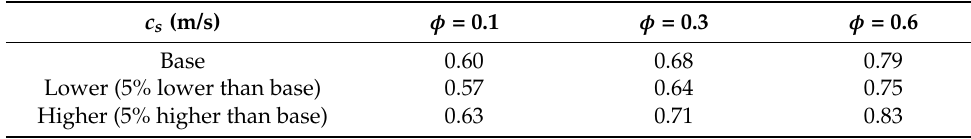
Table 3. Tested sound speed for different amplitude ratios.